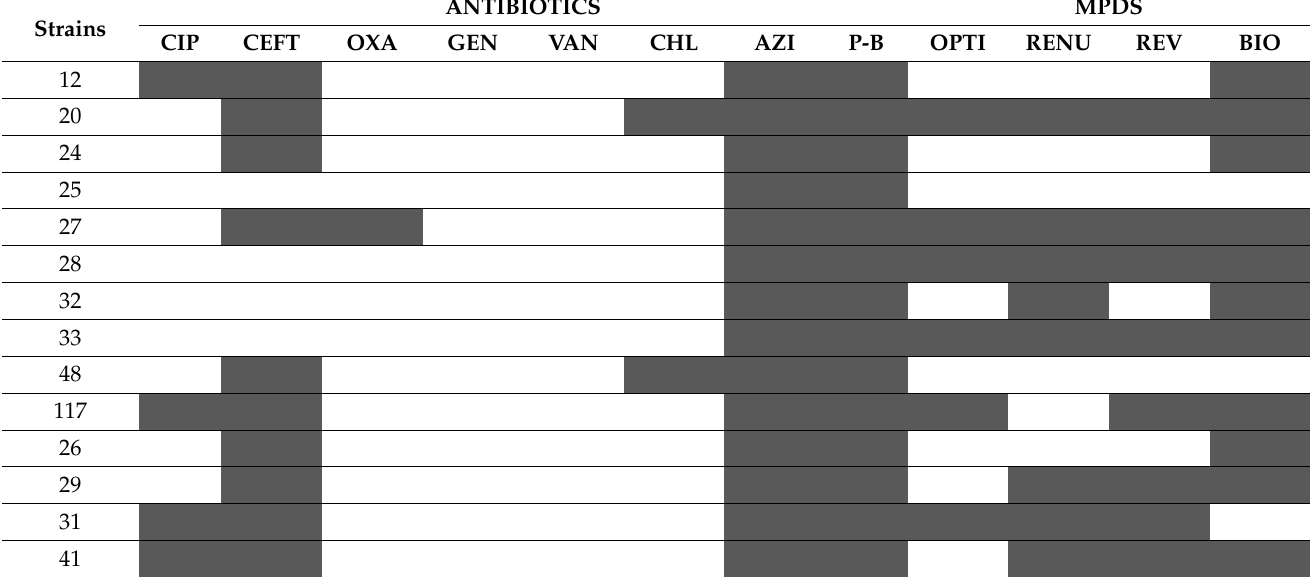
Table 3. Relative susceptibilities of contact lens-related niCIE isolates to antibiotics and MPDSs. ANTIBIOTICS Strains